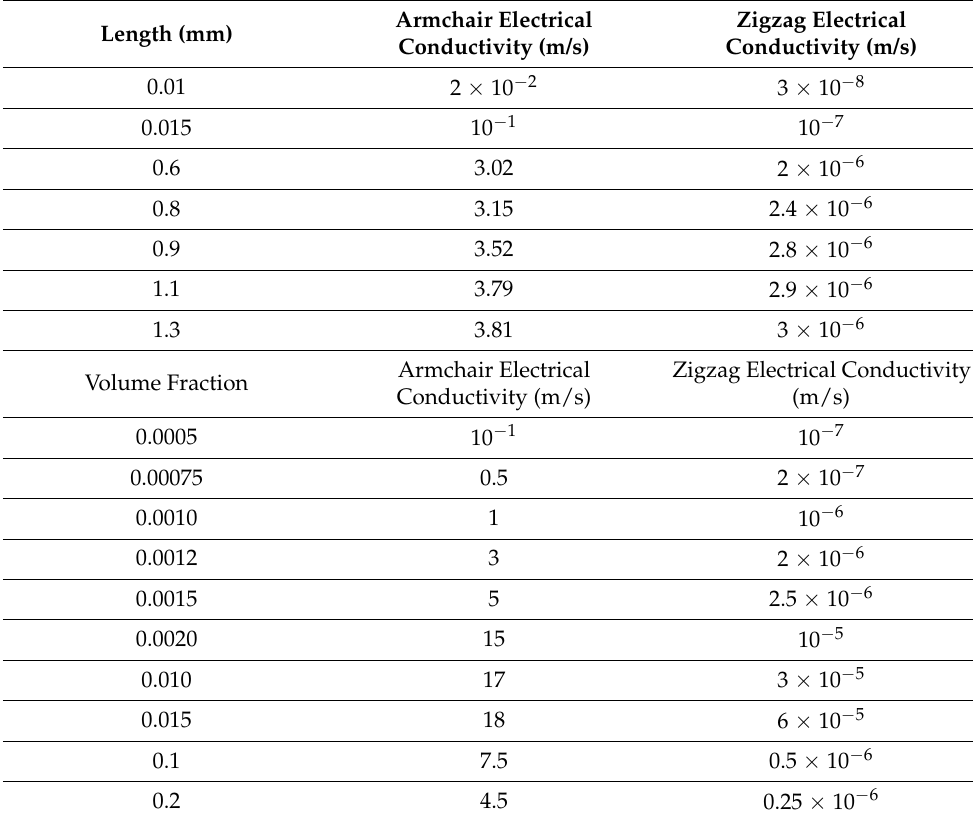
Table 2. The electrical conductivities of armchair and zigzag SWNTs with different volume fractions of CNTs in a composite with an aspect ratio ranging from 7.5 × 10 3 to 15 × 10 3 , and with different lengths at a volume fraction of 0.0005 and a diameter of 1–2 nm [66,70]. Armchair Electrical Zigzag Electrical Length (mm) Conductivity (m/s) Conductivity (m/s) 0.01 2 × 10 −